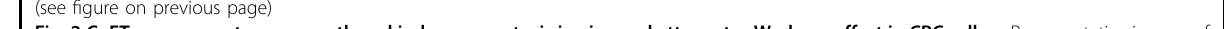
Fig. 2 CuET suppresses tumor growth and induces apoptosis in vivo and attenuates Warburg effect in CRC cells. a Representative images of nude mice tumors in each group. b Tumor volume was measured from the 12th day after tumor cells were inoculated in each group ( n = 5). c , d Apoptosis induction was examined by TUNEL assay and Western blot. TUNEL staining showed apoptosis in tumor tissue (the apoptotic cells were expressed in brown) ( c ). Western blot of Bax, Bcl-2, Caspase 3 from the lysates of the tumors in the primary tumor xenograft mice ( d ). e Bulb map of KEGG and GO pathway analysis for HCT116 cells treated with CuET, differential expression of genes related signi fi cantly enriched signaling pathway. X-axis represented the ratio of enriched differential genes in each pathway. Y-axis showed the name of statistics pathway enrichment. The area of each node represented the number of enriched differential genes. The p-value was indicated by different color changes from blue to red. f GSEA used to identify the differential gene pro fi les between HCT116 treated with CuET and controls. g – i Extracellular lactate production ( g ), cellular ATP level ( h ), and cellular glucose uptake ( i ) were measured in HCT116 cells treated with CuET. j Extracellular acid ratio (ECAR) upon cells was measured after HCT116 treated with different concentrations of CuET. Data in b , c , g – j are presented as the mean±SD from at least three